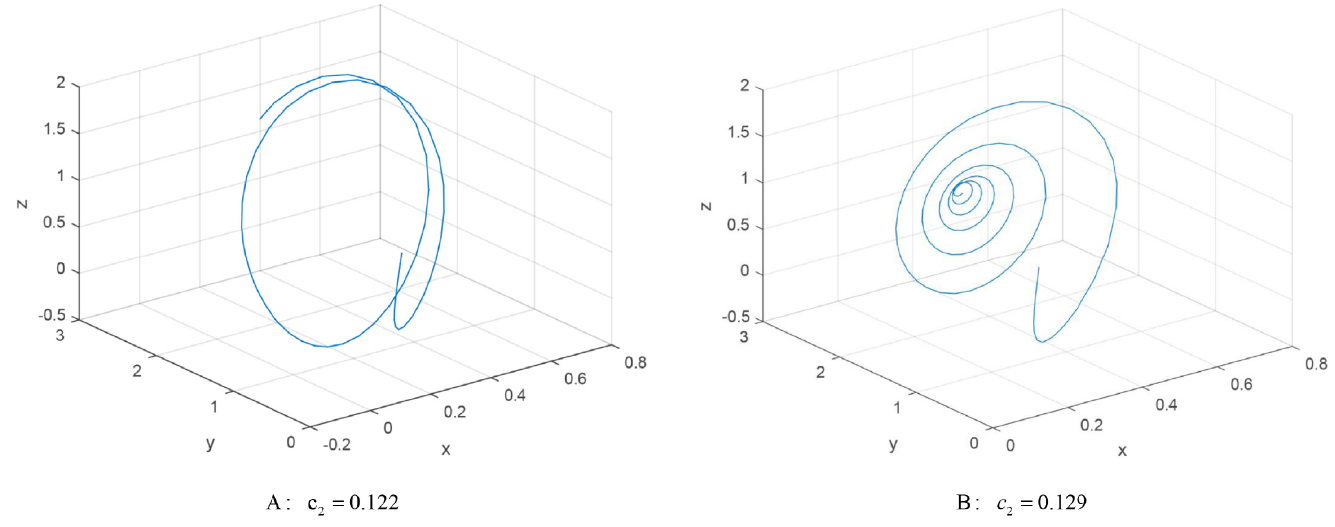
Fig 6. The stable state of the GDDS. A: The limit circle with c 2 = 0.122. B: The equilibrium with c 2 = 0.129.